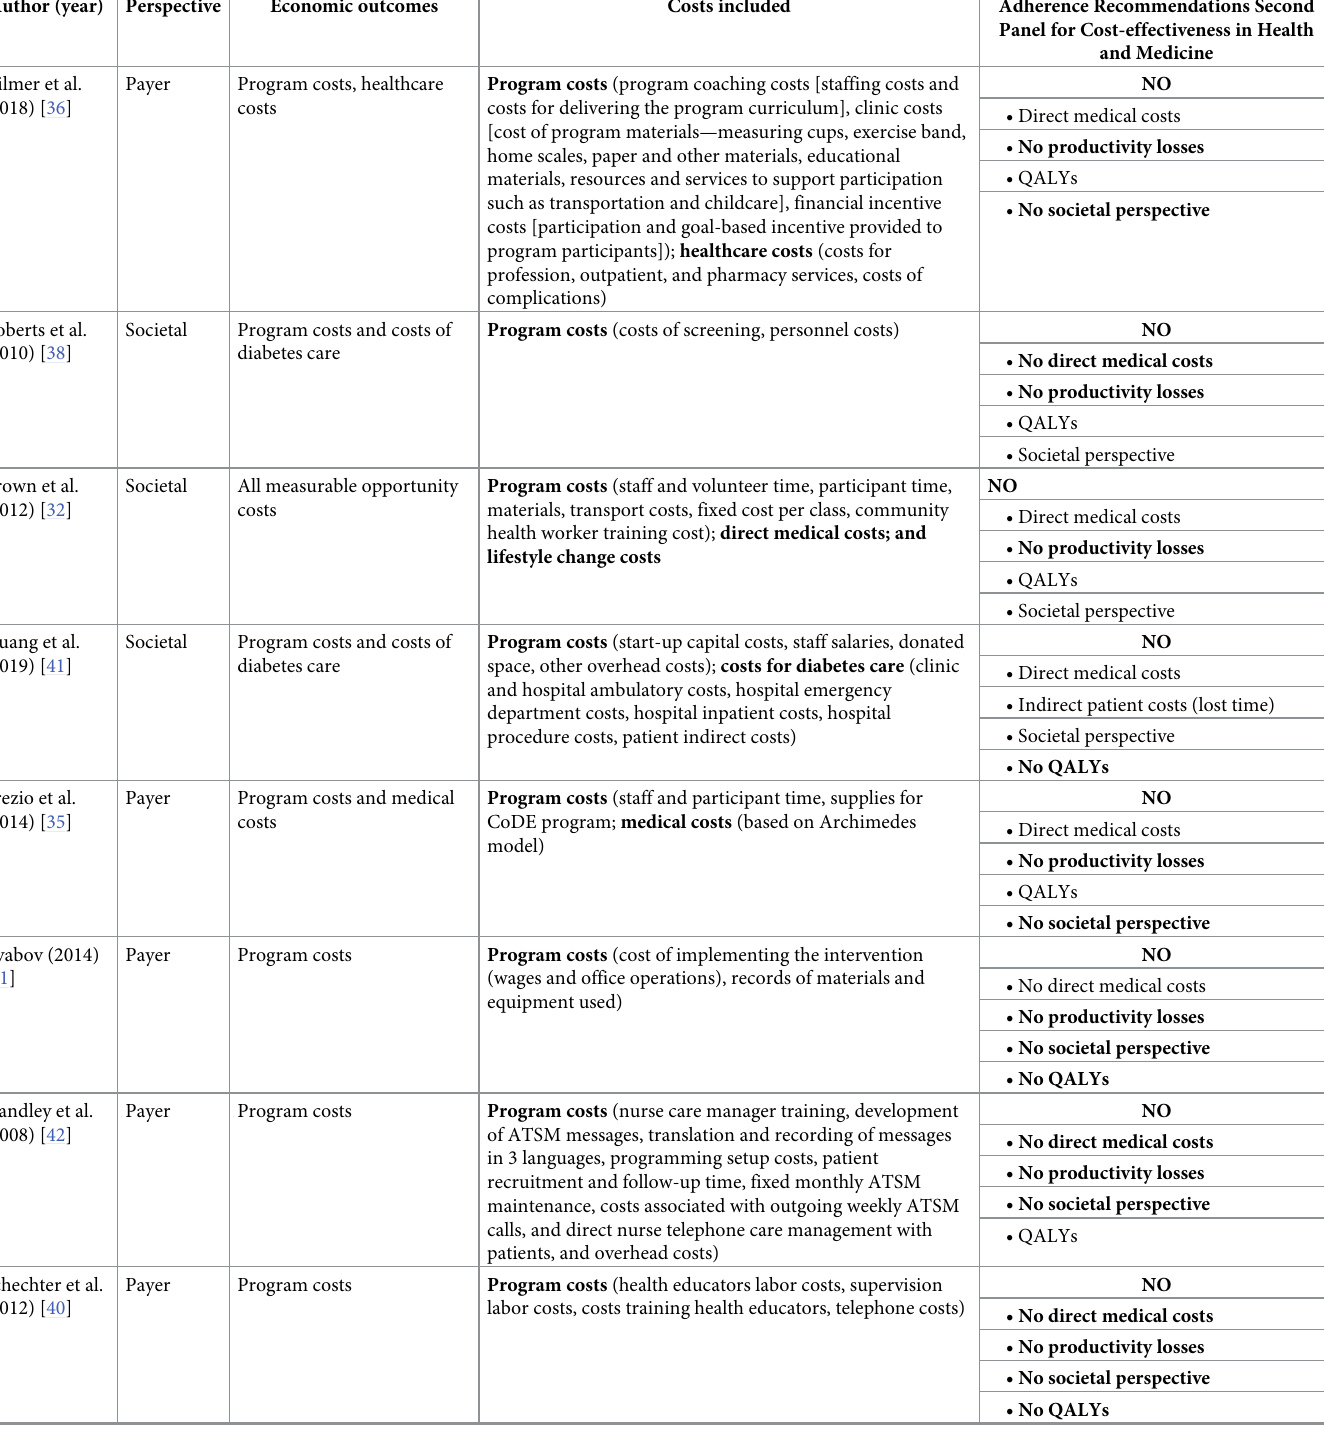
Table 4. Cost calculation for the studies included in the